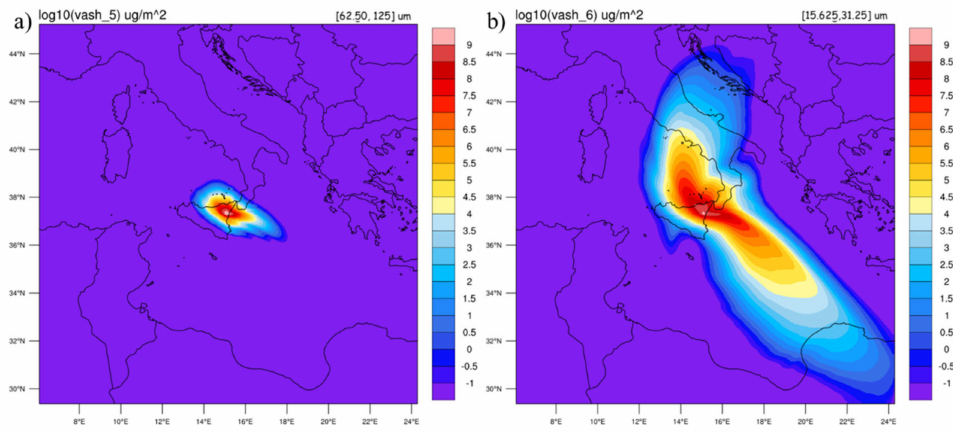
Figure 9. Transportation of volcanic ash ( a ) vash_5 and ( b ) vash_6, in the period from December